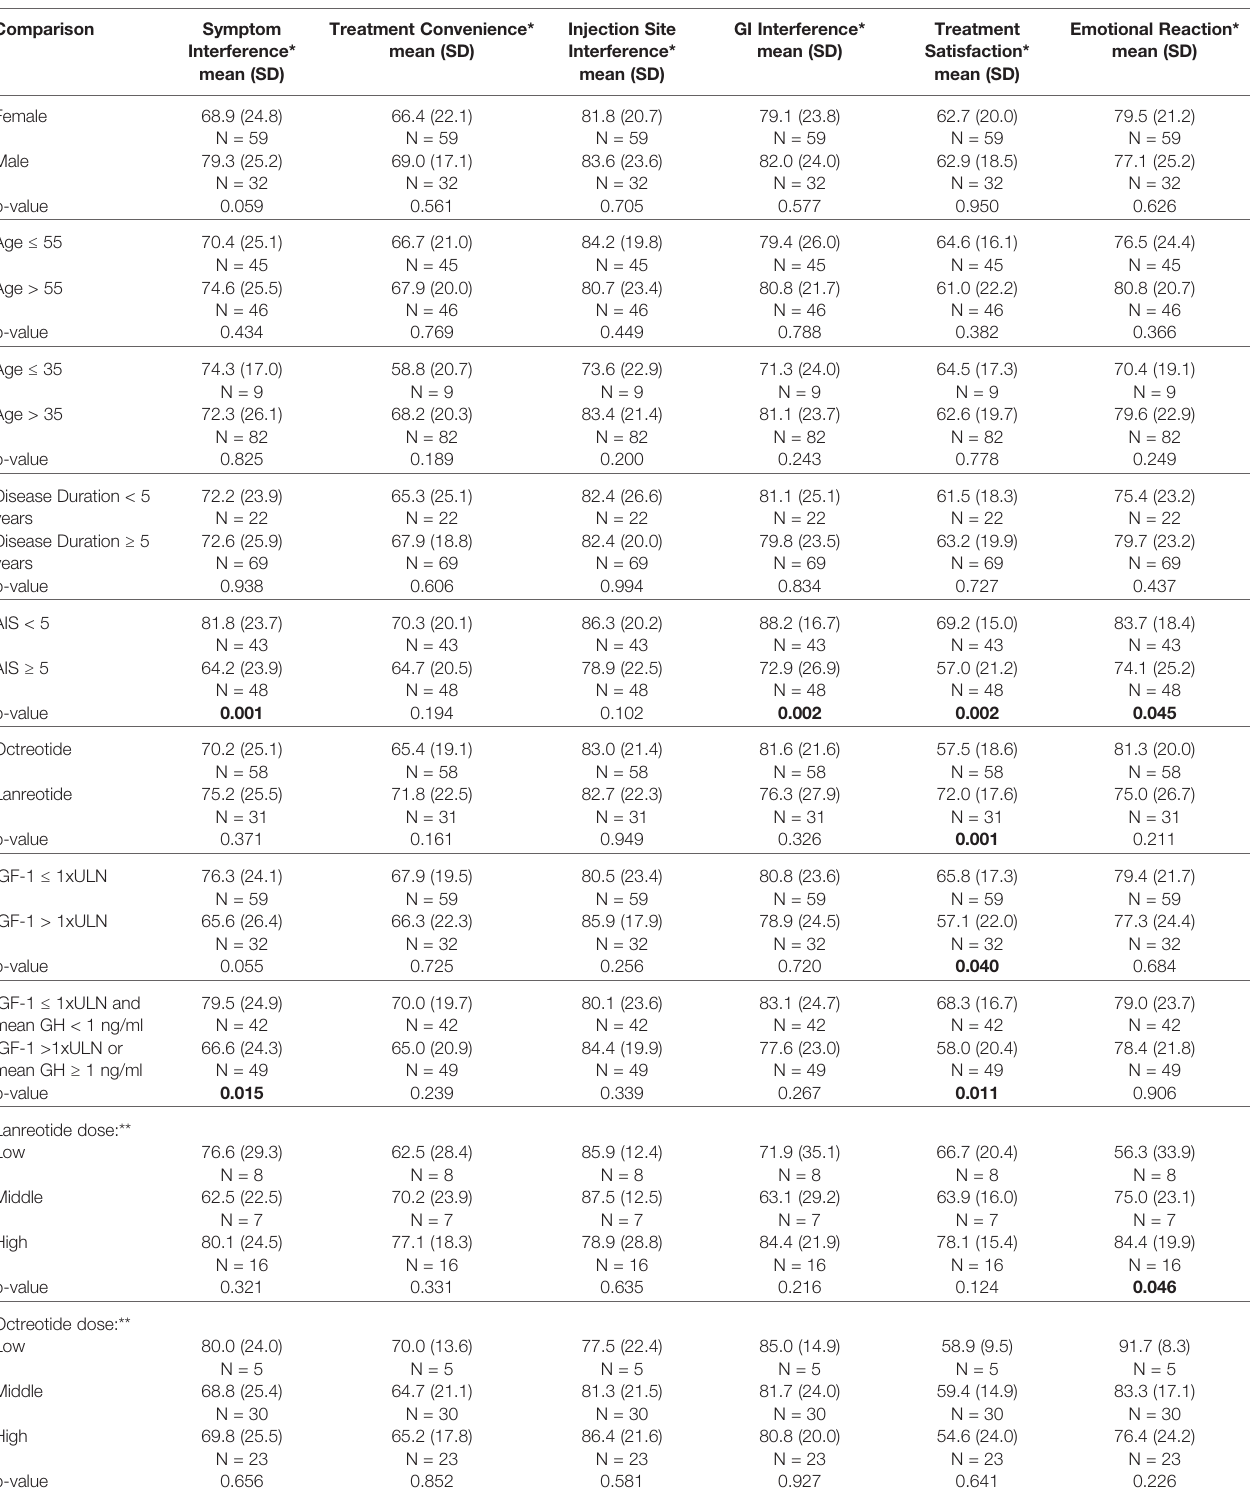
TABLE 3 | Acro-TSQ domains by patient